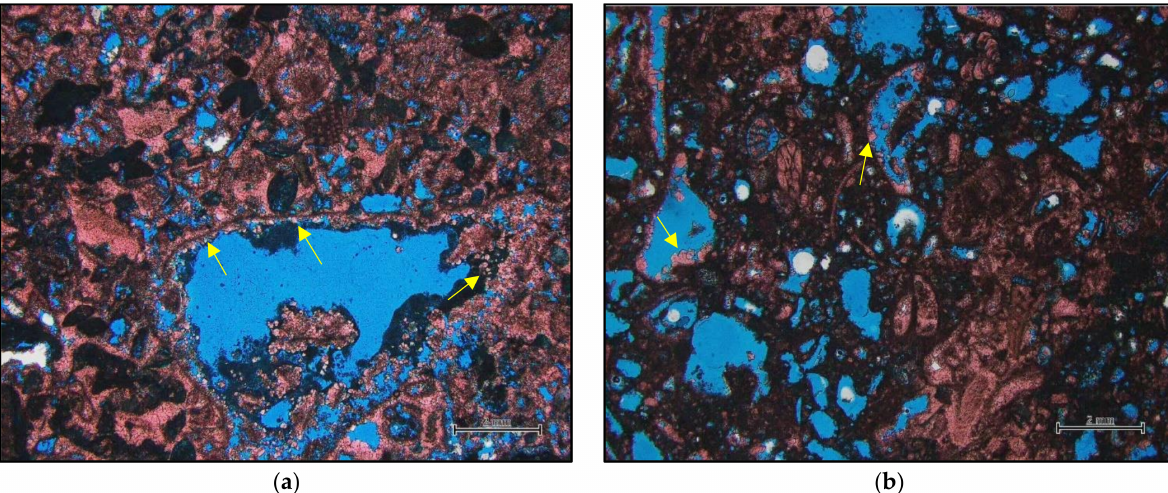
Figure 12. ( a ) More than 2 mm wide moldic porosity resulting from the dissolution of red algae and filled with blocky calcite cements (yellow arrow) are observed in a thin section at Jintan-3 well (1778.38 m depth). ( b ) More than 10 bioclasts dissolved and some of the pore filled with blocky calcite cements (yellow arrow) observed on thin section at Jintan-3 well at 1829.05 m depth.